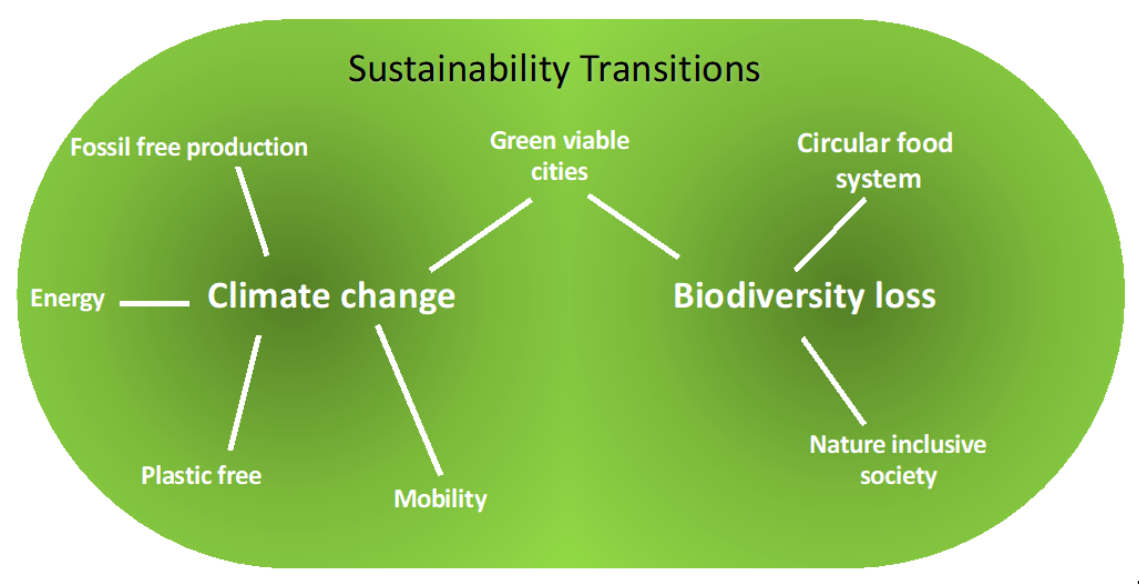
Figure 3. Sustainability transitions (energy, mobility, circular food system, viable cities, nature-inclusive society, fossil fuel-free production) necessary to ensure that society can live within “a safe operating space”, as defined by Raworth (2012), and having an impact on the circular household from the perspective of two major global challenges: climate change and biodiversity loss.